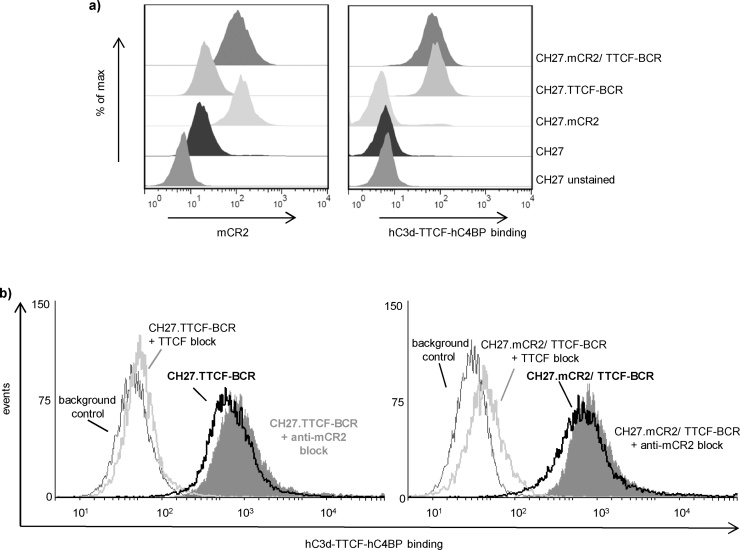
Recombinant hC3d-TTCF-hC4BP binds CH27 via TTCF specific BCR instead of mCR2.a) Untransfected CH27B cells and various CH27 transfectant clones were incubated with biotinylated anti-mCR2 monoclonal antibody 7E9 (left panel) or biotinylated hC3d-TTCF-hC4BP (right panel). Following the addition of SA-PE, fluorescence intensity was measured and histograms displayed using FlowJo. (b). Binding of biotinylated hC3d-TTCF-hC4BP to CH27.TTCR-BCR and CH27.mCR2/TTCF-BCR clones in the presence or absence of TTCF and the mCR2 blocking antibody 7G6. Binding was detected with SA-PE and histograms were overlapped using FlowJo. 10,000 cells were collected.